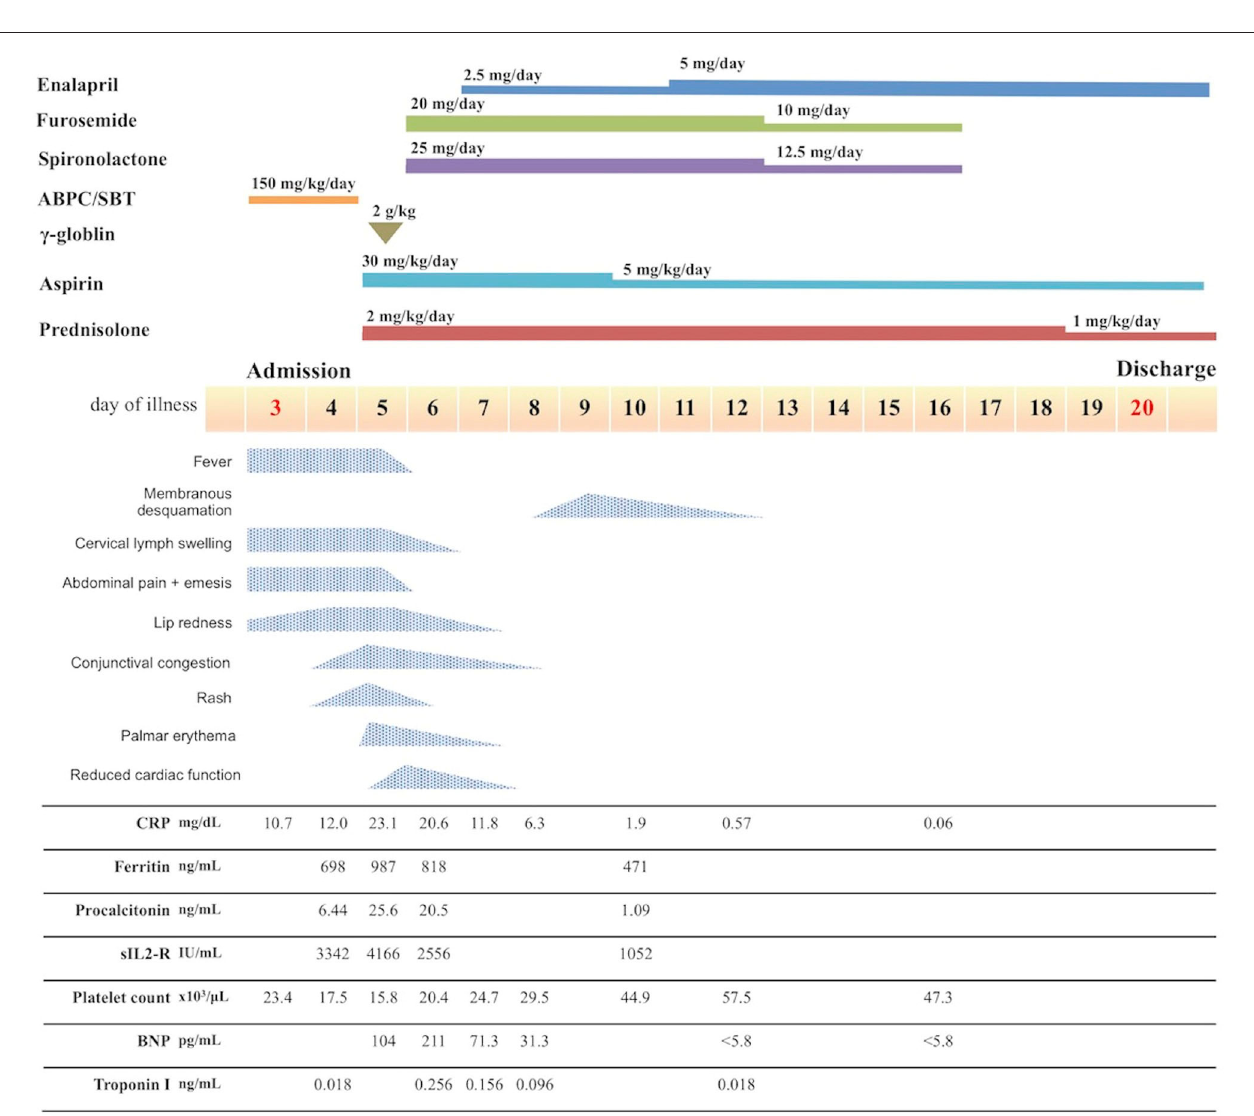
screening panel (Bio-Rad Laboratories Inc.). We also